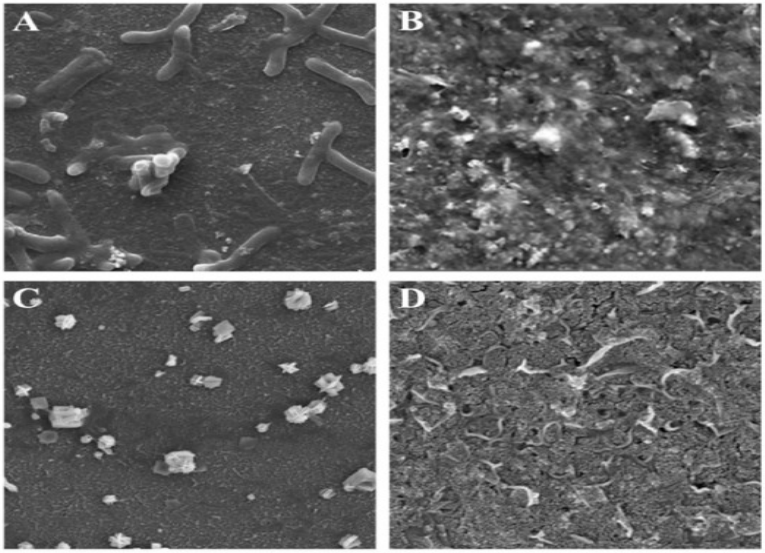
Figure 2. SEM image of fouling. ( A ) Biofouling; ( B ) Organic fouling; ( C ) Inorganic fouling; ( D ) Colloidal fouling [12].